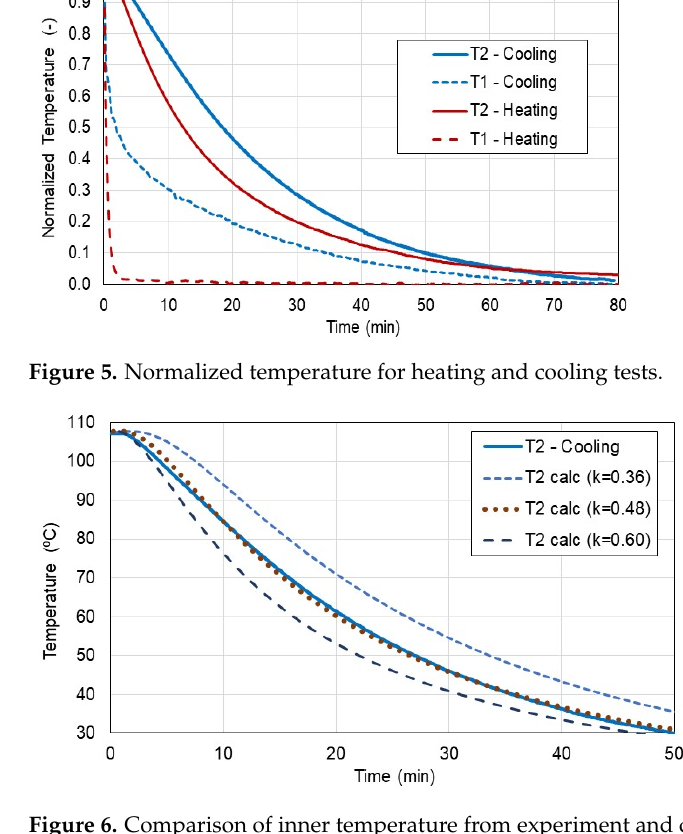
Figure 6. Comparison of inner temperature from experiment and calculations.